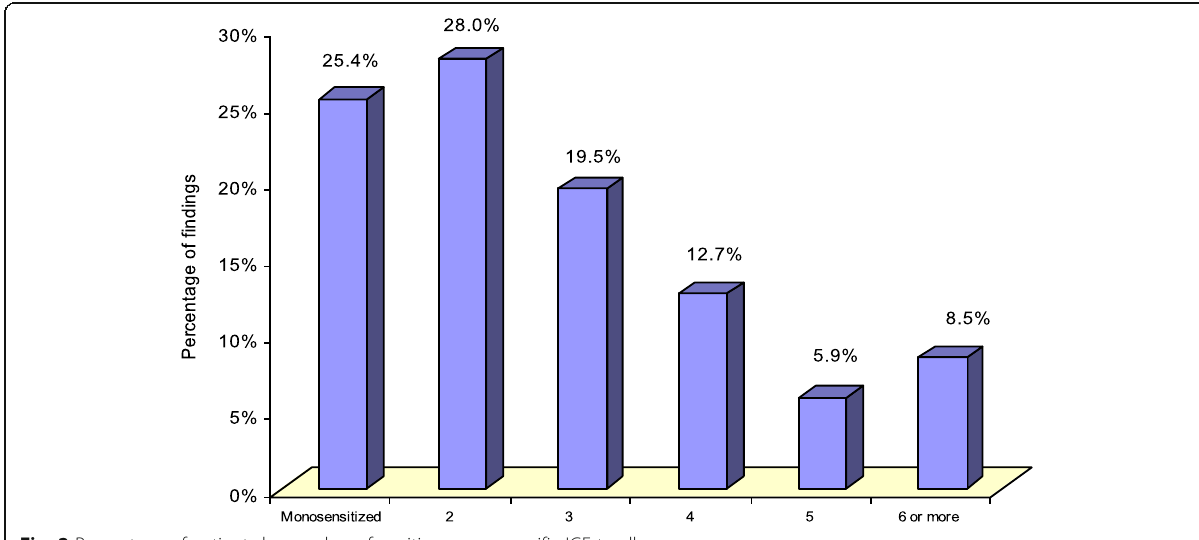
Fig. 2 Percentage of patients by number of positive serum-specific IGE to